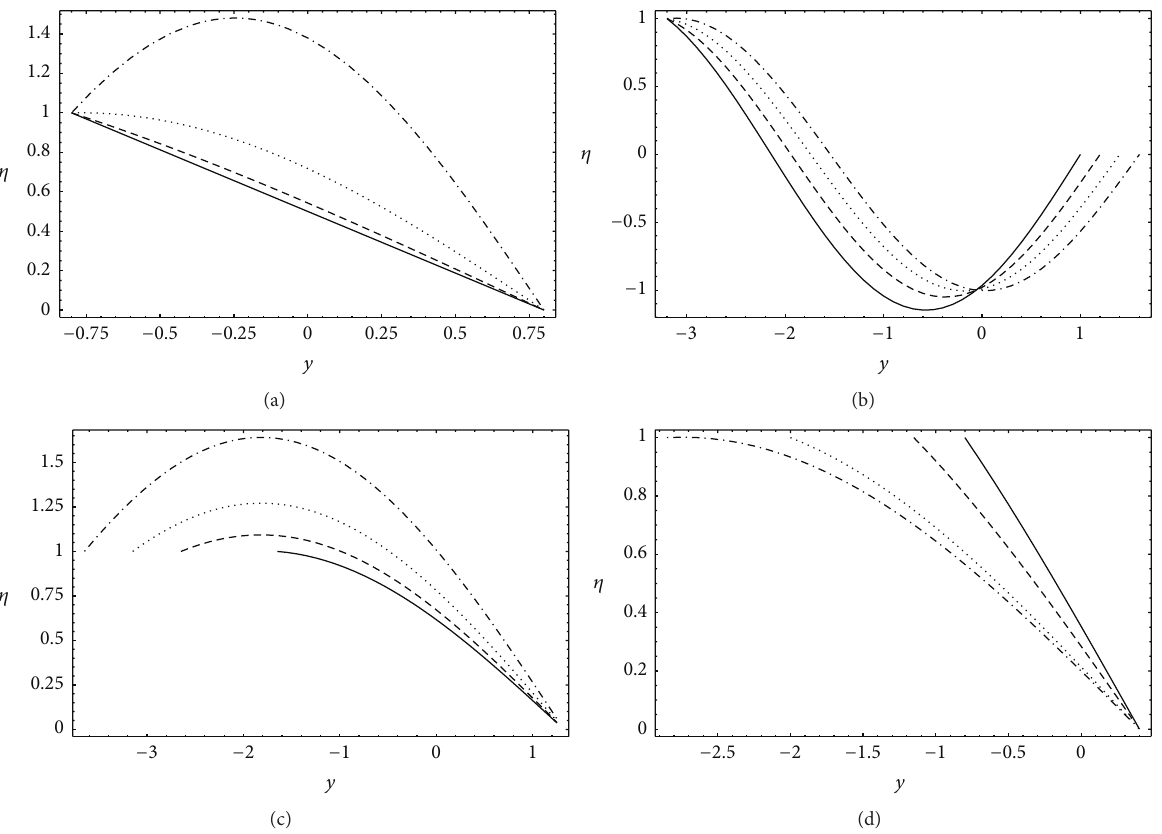
𝑁 = 0.0 , 𝑁 = 0.5 , 𝑁 = 1.0 , and ... — ––– 𝑎 = 0.0 , 𝑎 = 0.2 , 𝑎 = 0.4 , and 𝑎 = 0.6 , (c) 𝑎 = 0.6 , 𝑥 = 1 , 𝜙 = 0 , 𝑁 = 0.5 , 𝑑 = 1.0 , ... . . . — ––– — 𝜙 = 0𝜋/4 , 𝜙 = 𝜋/4 , 𝜙 = 2𝜋/4 , and 𝜙 = 3𝜋/4 . ... . . . — –––